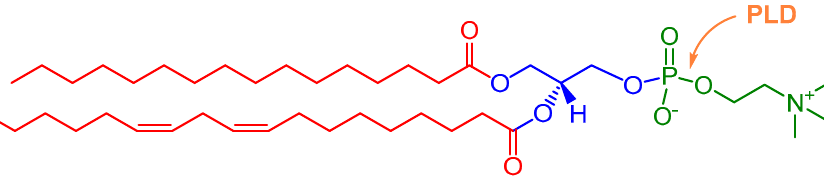
Figure 1. General structure describing the PC (here 1-palmitoyl-2-linoleyl-PC) structure composed by two acyl chains (in red), a glycerol backbone (in blue) and a polar head (in green). The attack position cleaved by PLD is also indicated with the orange arrow.